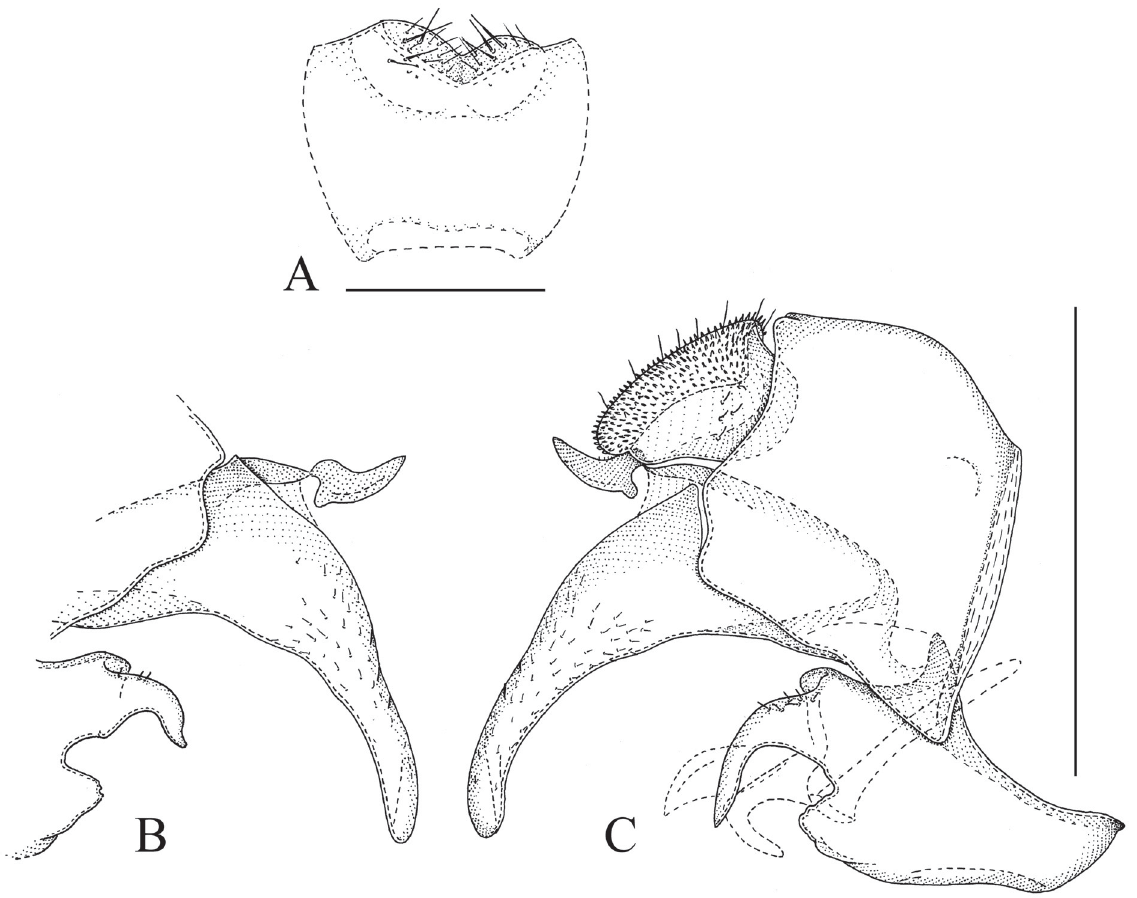
Fig. 76. Sphegina (Asiosphegina) plautus sp. nov., holotype, ♂ . A . St ernum IV, ventral view. B . Posterior part of genitalia, left side, lateral view. C . Genitalia, right side, lateral view. Scale bars = 0.5